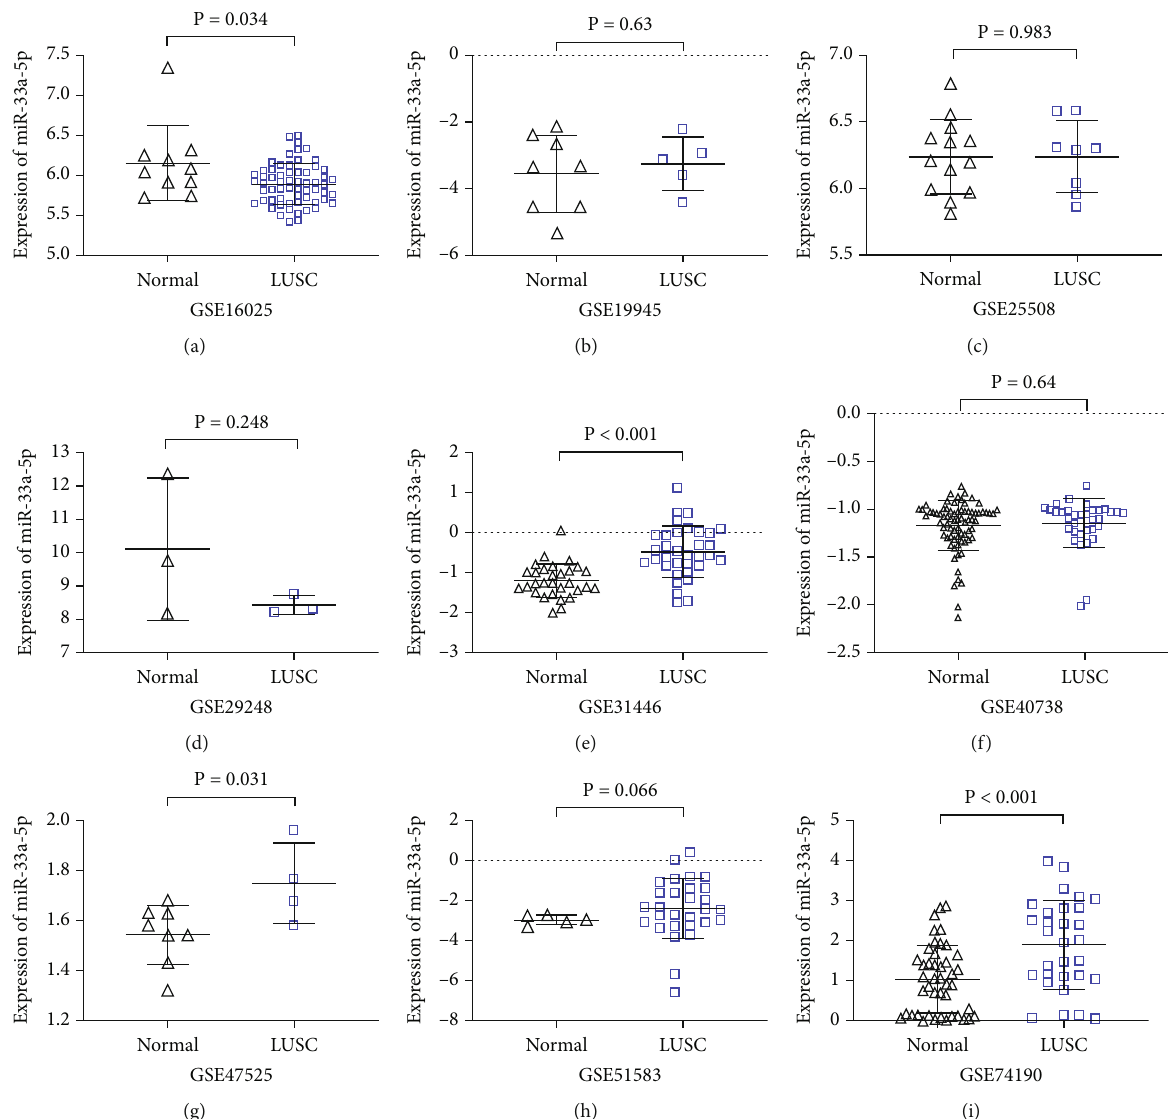
Figure 3: miRNA-33a-5p expression in LUSC and nontumor tissues based on miRNA microarrays. The scatter plots display the di ff erential expression levels of miRNA-33a-5p in LUSC and noncancer tissues for each of the included microarray datasets. Data are expressed as the means ± SD , and P < 0 : 05 indicates a statistically signi fi cant di ff erence when compared to the normal control. LUSC: lung squamous cell